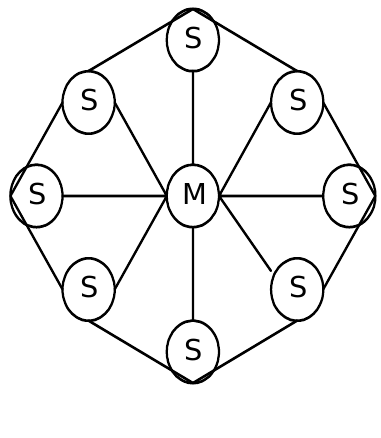
Figure2. Coarse-grained model